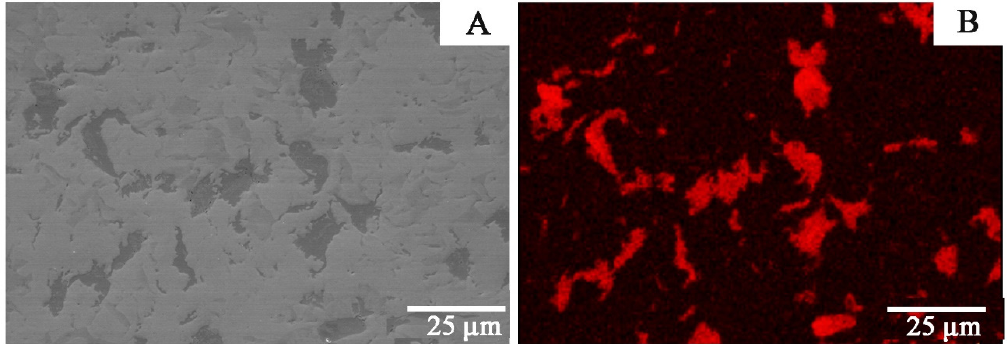
Figure 4. The Zr-2.5Cu microstructure obtained by the extrusion method is presented (cross-section): ( A ) SEM microstruc- ture; ( B ) Cu distribution for this microstructure.